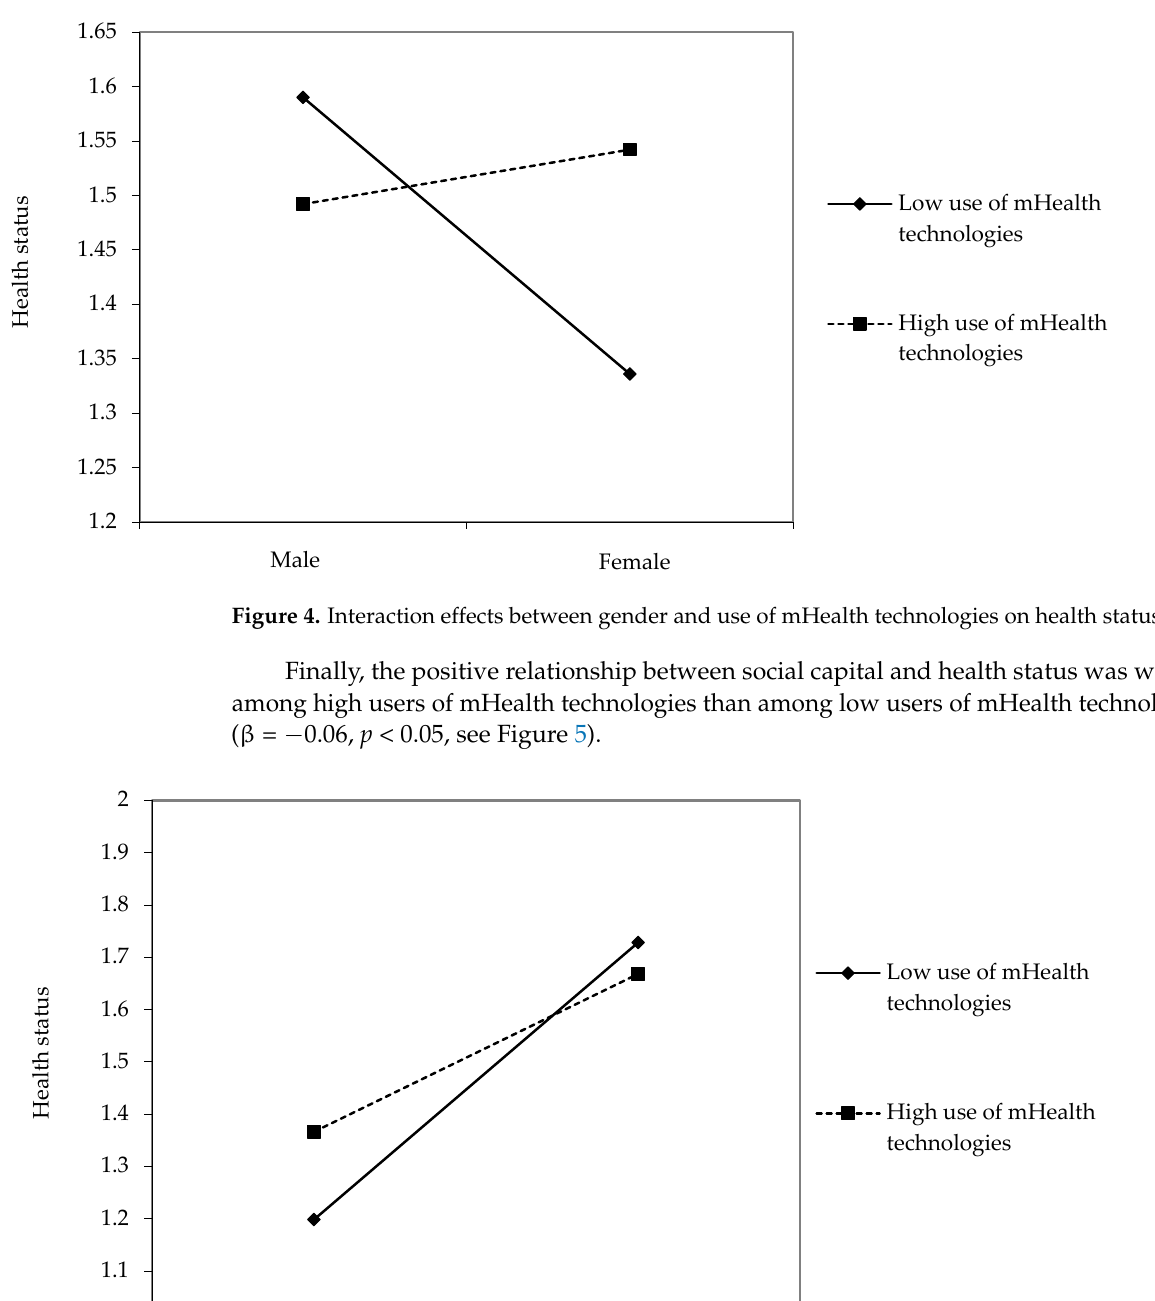
Figure 3. Interaction effects between social capital and use of mHealth technologies on health self- efficacy.